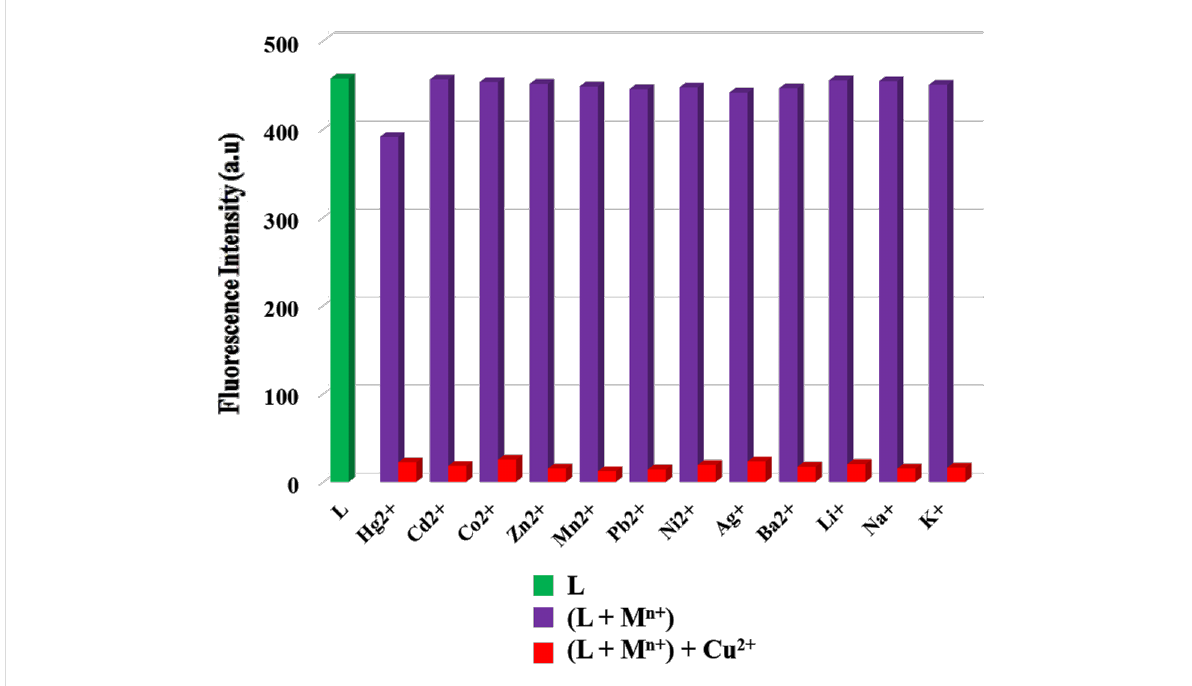
Figure 6: Fluorescence intensity of L (1.0 × 10 − 5 M) upon the addition of 10 equiv Cu 2+ in the presence of 10 equiv of other metal ions (as perchlo- rate salts) in MeCN.